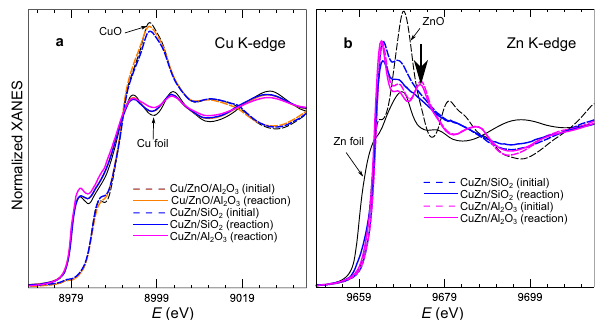
Fig. 2 Operando XANES spectra. a Cu K-edge and b Zn K-edge XANES spectra for Cu/ZnO/Al 2 O 3 , CuZn/SiO 2 and CuZn/Al 2 O 3 catalysts in their initial state (dashed lines), and under operando conditions in CO 2 + CO + H 2 , p = 20 bar, T = 220 °C (solid lines). The reference spectra for CuO and ZnO (dashed lines), Cu and Zn foils (solid lines) are also shown. The vertical arrow in b marks the signature of the zinc spinel